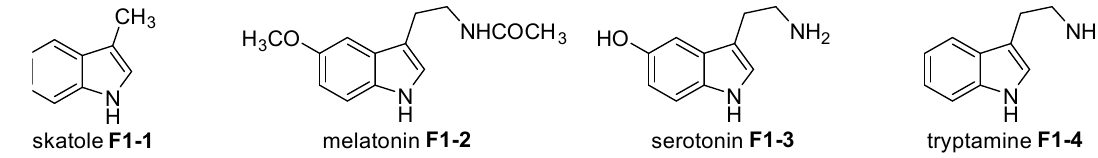
Figure 1. Structures of naturally occurring indole derivatives.